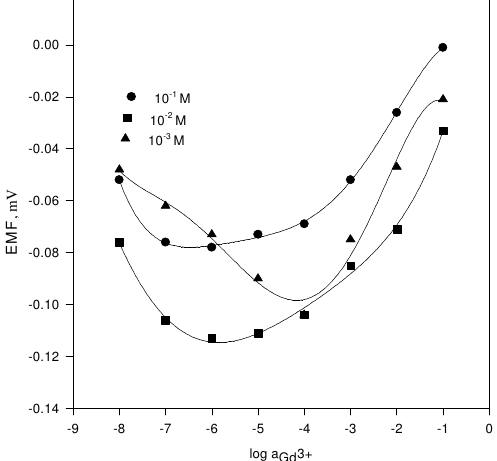
Figure 1(b). Curves for Gd(III) selective electrode (50% membrane) based on ZrWP in epoxy resin and also the effect of internal